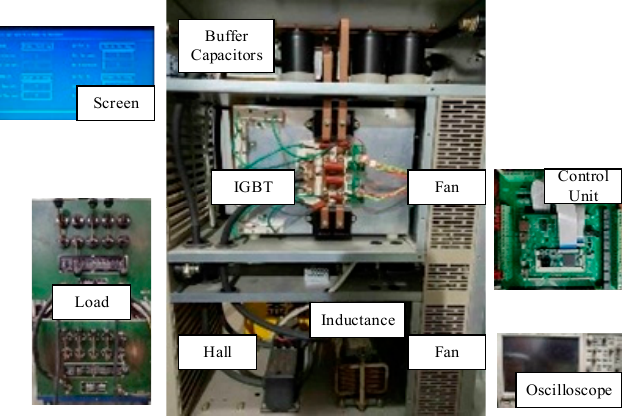
Figure 12. Experimental prototype and experimental conditions. Table 1. Experimental specifications.